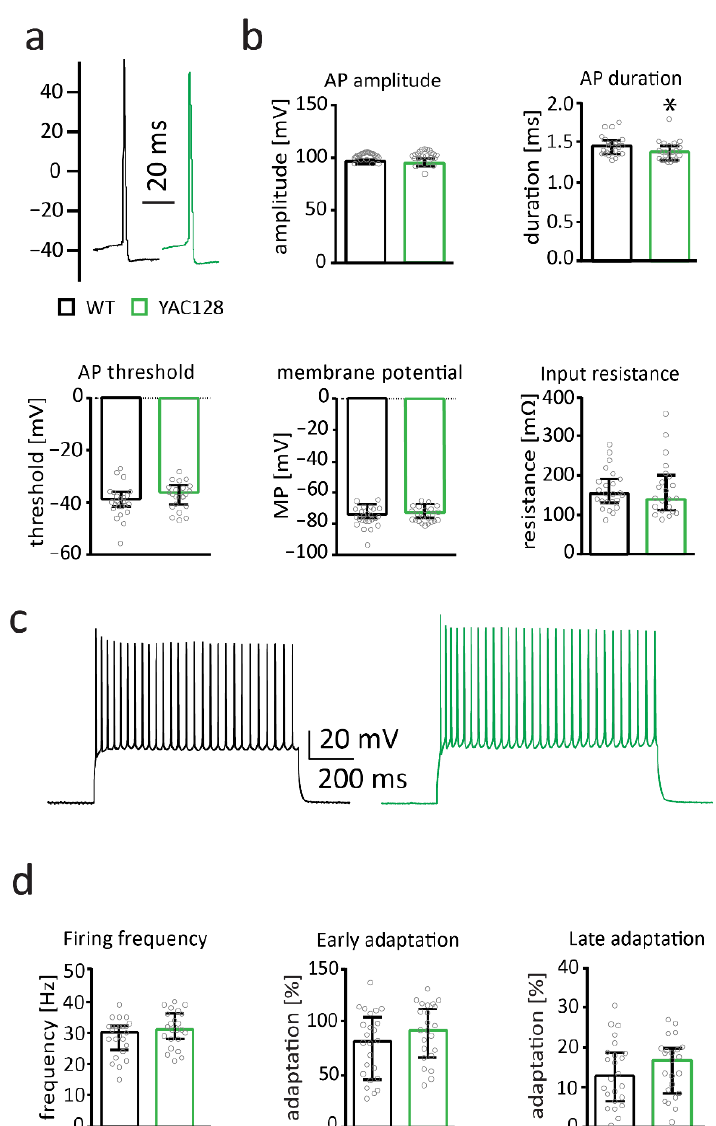
Figure 3. Membrane properties are by and large unaltered in 12-month-old YAC128/BL6 mice. ( a ) Sample traces of action potentials (APs) recorded from MSNs of WT (black) and YAC128/BL6 (green) mice. ( b ) Bar graphs of AP threshold, amplitude, threshold and input resistance (WT n = 24; YAC128/BL6 n = 23). ( c ) Sample traces of AP firing induced by current injection. ( d ) Bar graphs of firing frequency, and early and late adaptation of MSNs from WT ( n = 24) and YAC128 ( n = 23) mice. MP = membrane potential. Bar graphs are depicted as median ± IQR. * = p < 0.05